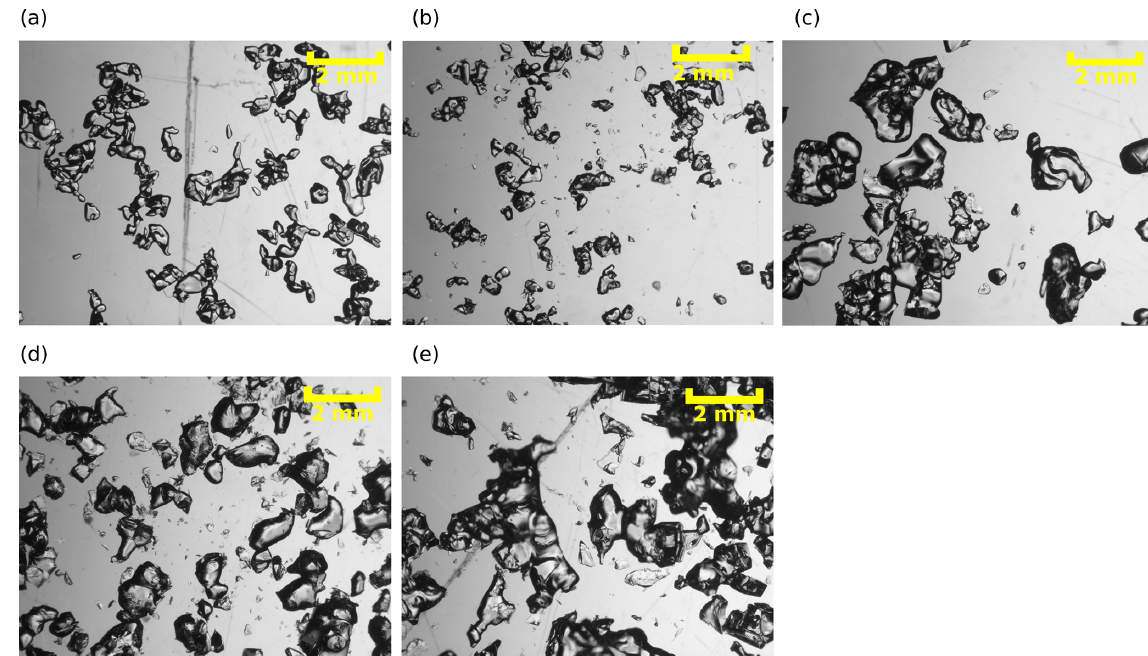
Figure 2. Pictures (Leica Z16 APO) of the undisturbed grain shape and the artificial particles (fragments) for the five snow types that we used for our sampling procedure: (a) rounded and decomposed (type A), (b) small and rounded (type B), (c) large and rounded (facets)(type C), (d) large and rounded (type D), and (e) refrozen, wet snow (type E). The yellow scale bar is 2mm. We produced the pictures as part of our sampling procedure (see Sect.